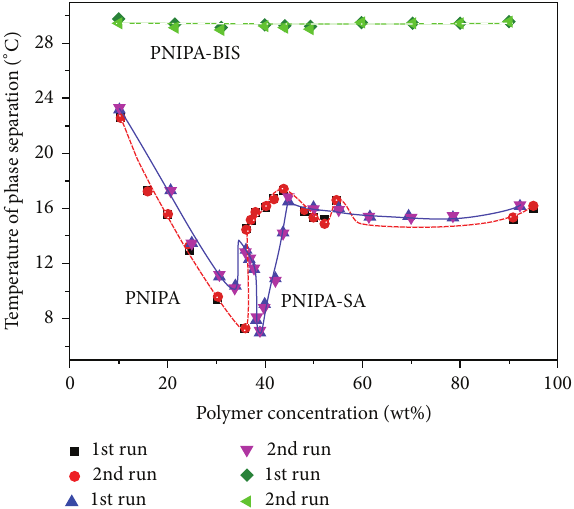
Figure 8: Phase diagrams of PNIPA, PNIPA-SA, and PNIPA- BIS/water systems; onset values of LCST were taken from the TM- DSC plots (reversing heat flow) upon first and second heating at 5 ∘ C/min.